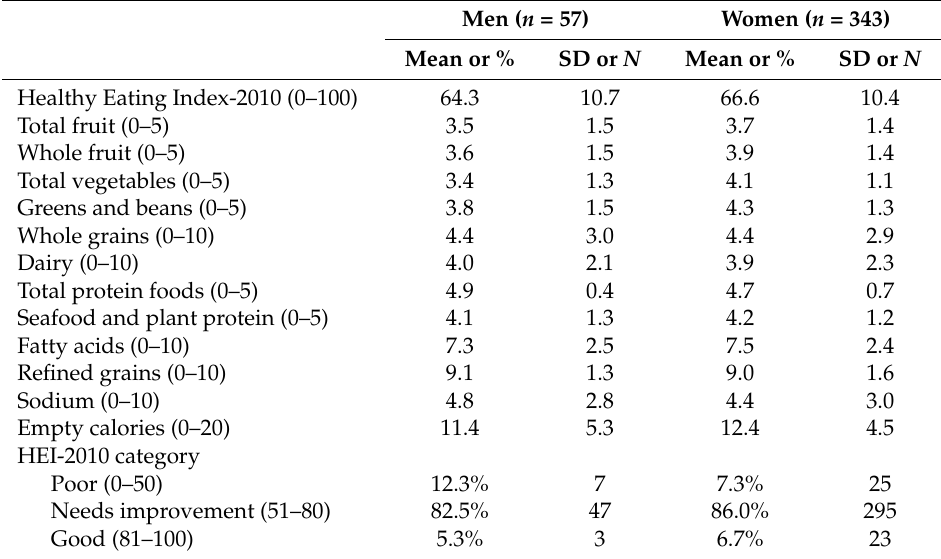
Table 3. Healthy Eating Index-2010 (HEI-2010) total and component scores of urban overweight and obese primarily African American older adults with osteoarthritis ( n = 400).